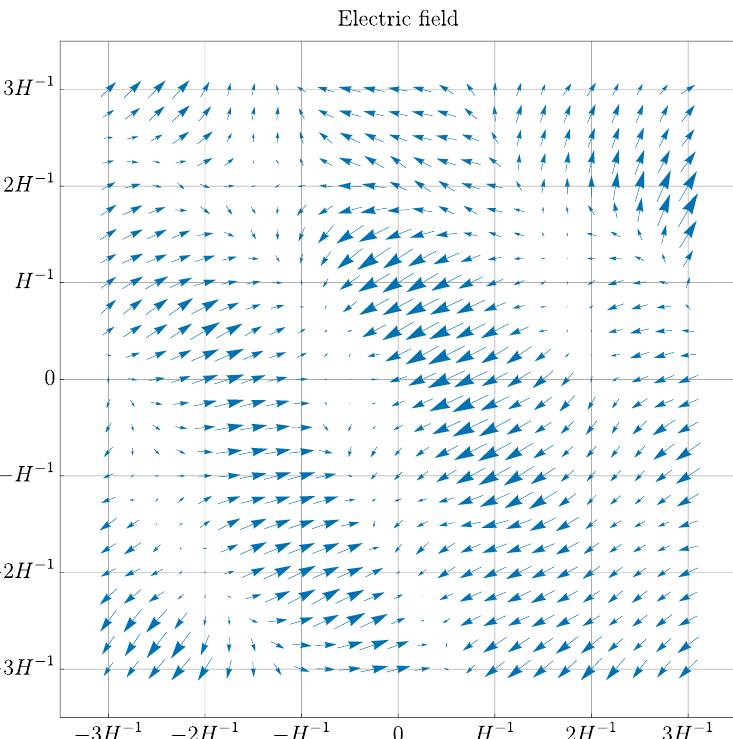
Figure 3. A two-dimensional visualization of the electric field at early times during radiation domination, obtained by randomly drawing from the power spectrum discussed in appendix A. magnitude and direction with typical magnitudes of O ( m A 0 H I )